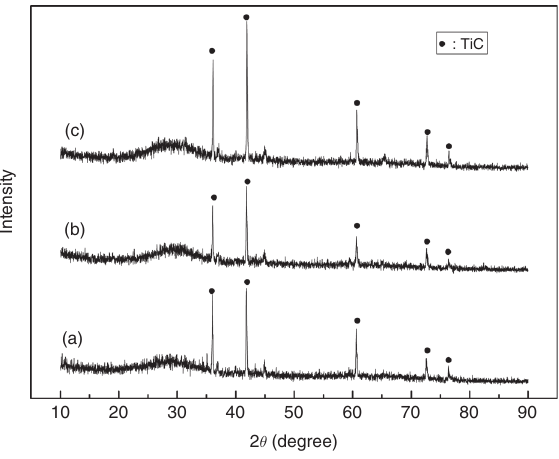
Figure 15: XRD results of reduced samples with carbon ratio of 1.0, 2 h, at 1,873 K for different additives: (a) 5 wt% CaCl 2 ; (b) 5 wt% Fe; (c)